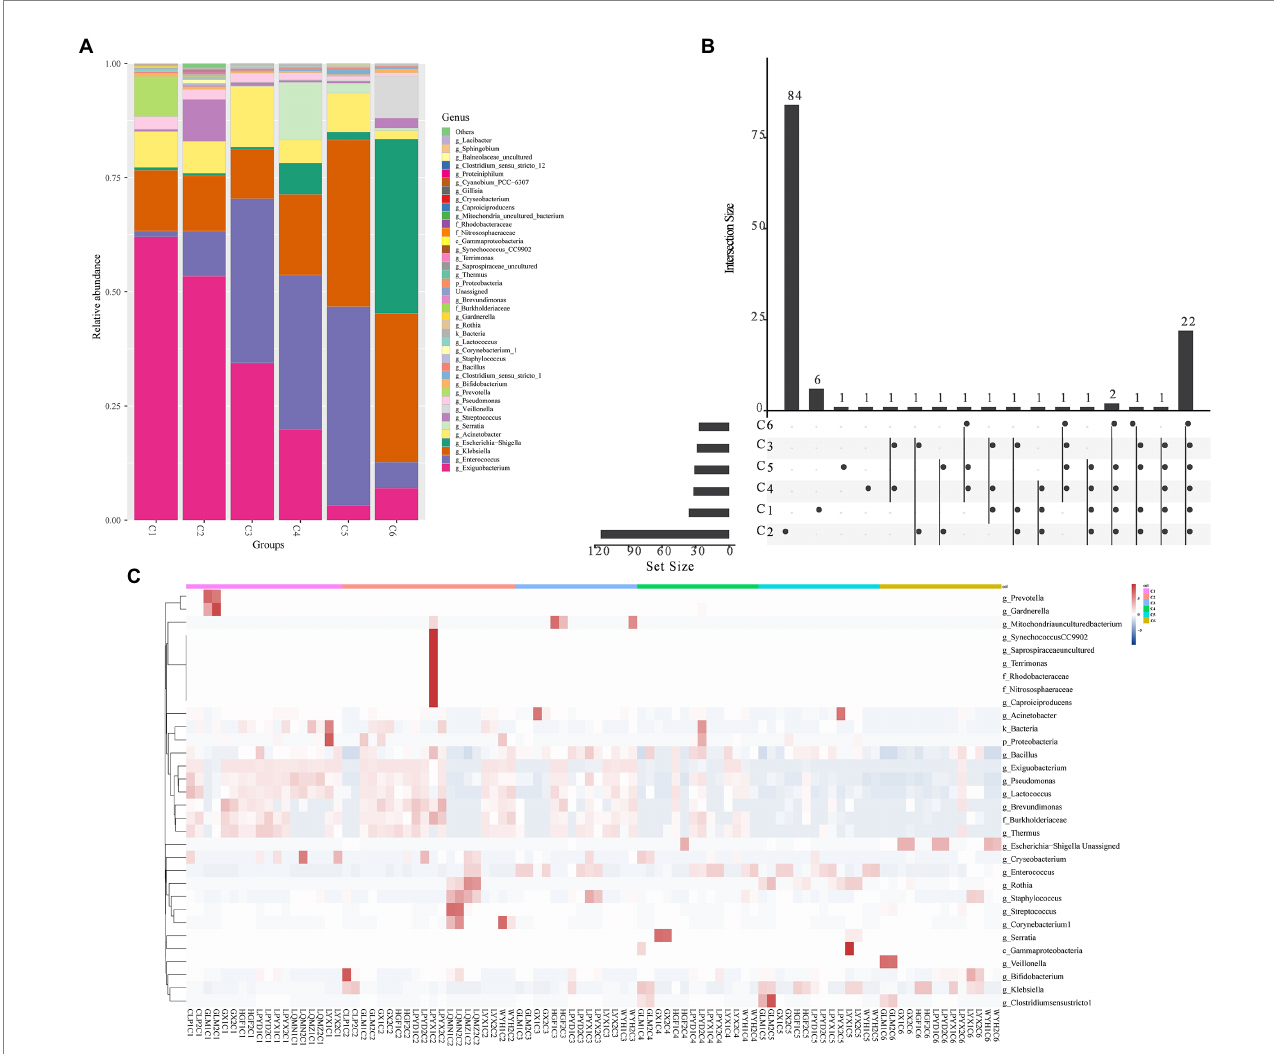
FIGURE 3 The top abundant genera of intestinal microorganisms enriched in 6 age time point groups of preterm infants. (A) Composition of the top 40 most abundant genera in the six time points (C1–C6). (B) Venn plot illustrating overlap of gut microbial genera among 6 age groups. (C) Heatmap showing the most abundant differentially expressed genera in the gut microbiota of the six time point groups. Single letters (g, f, and c) in front of names indicate the genus, phylum, and class,